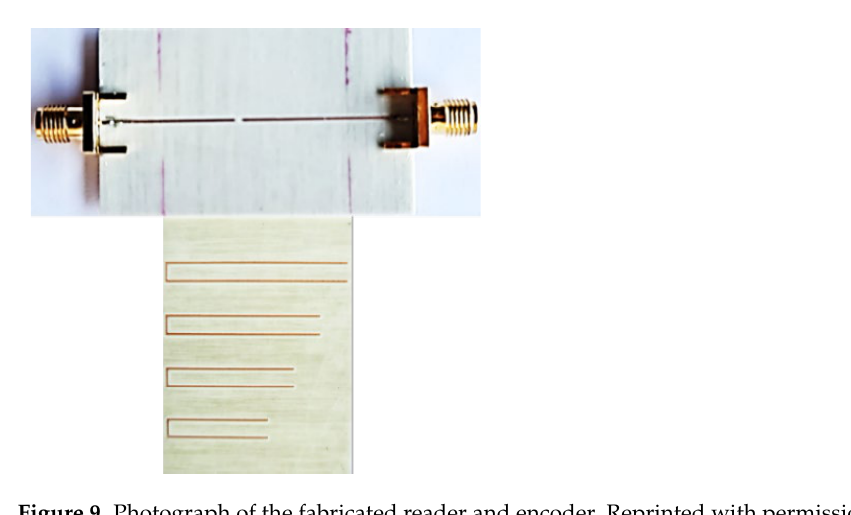
Figure 8. Simulation of the transmission coefficient for the resonance frequencies of the four C-shaped resonators of the encoder, as a function of the encoder displacement. The considered encoder is depicted in Figure 7. Reprinted with permission from [65].